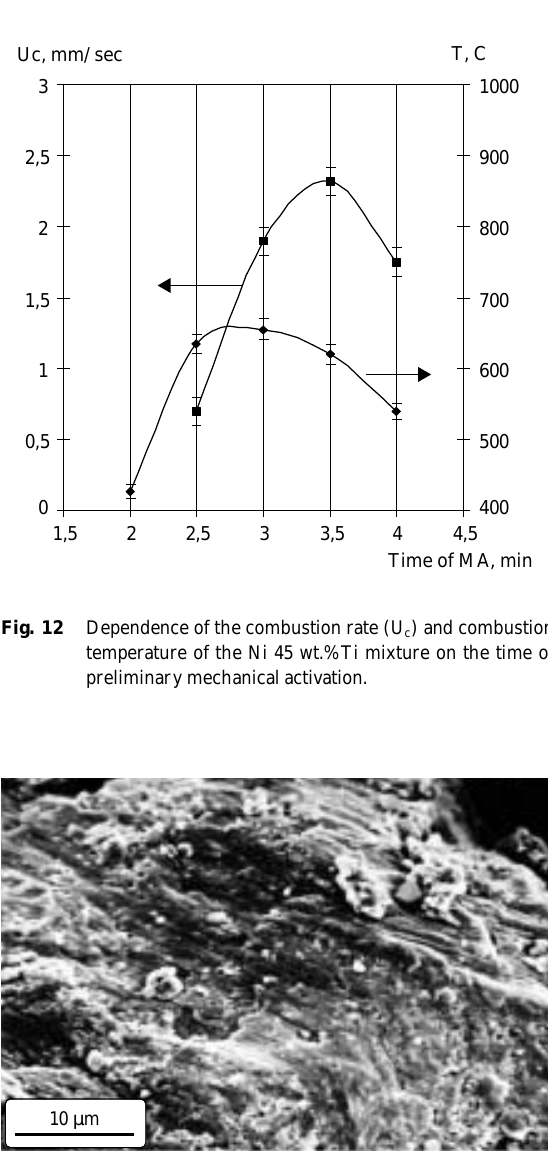
Fig. 13 Microphotograph of a Ni 45 wt.% Ti sample after mechani- cal activation for 2.5 min.